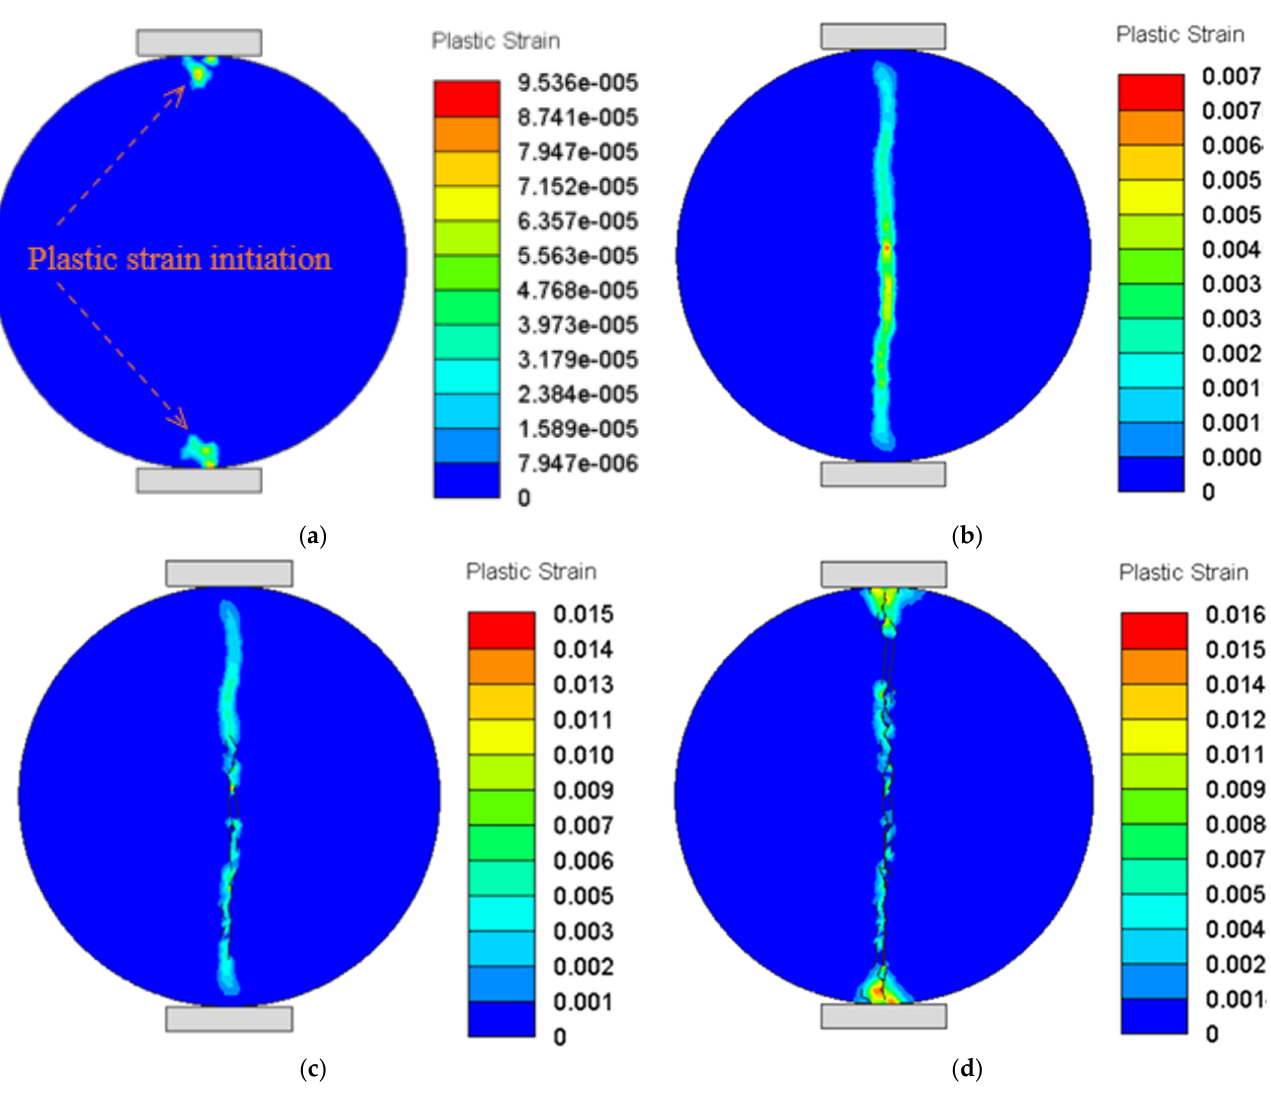
Figure 16. The plastic strain evolution with load for the Type II testing: ( a ) 17.5 kN, ( b ) 22.0 kN, ( c ) 20.0 kN (post − peak), ( d ) 7.7 kN (post − peak).